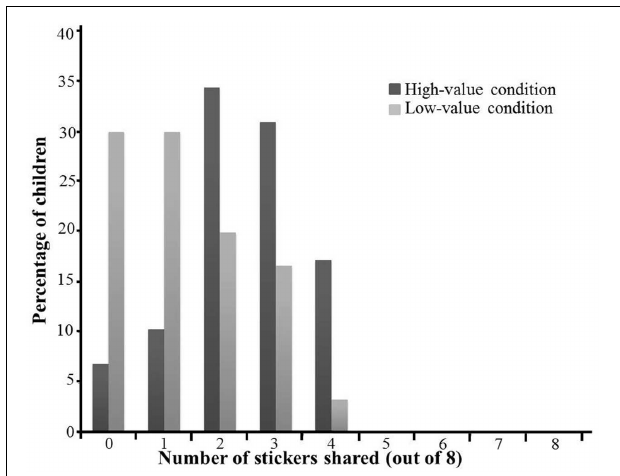
FIGURE 4 | Distribution of number of stickers shared in Experiment 2 by condition.